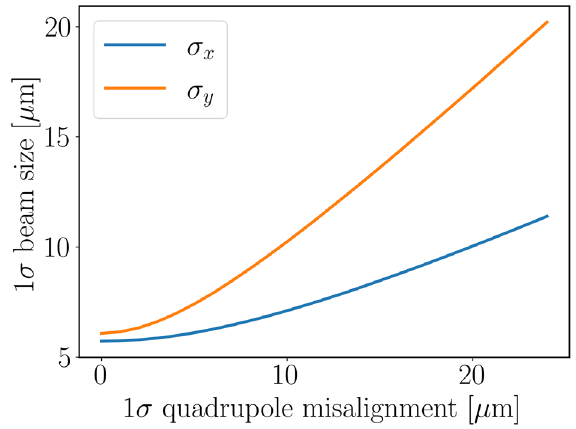
FIG. 7. Horizontal and vertical beam sizes averaged over 50 seeds with quadrupole misalignments sampled randomly from a Gaussian distribution with standard deviation given by the x axis.